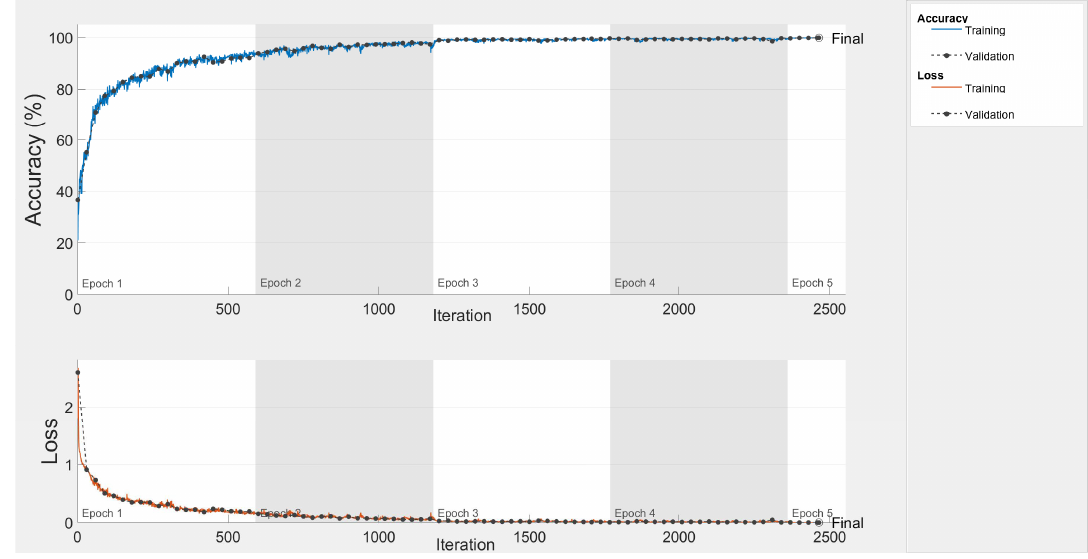
Figure 10. Accuracy and loss curve for the augmented